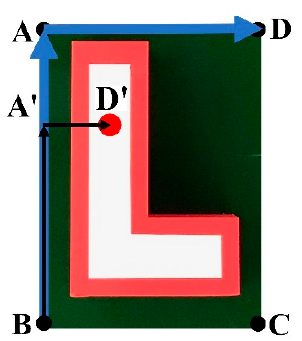
Figure 13. Example of the nonrectangular object with background used as the query image with reference vectors to locate the destination point.